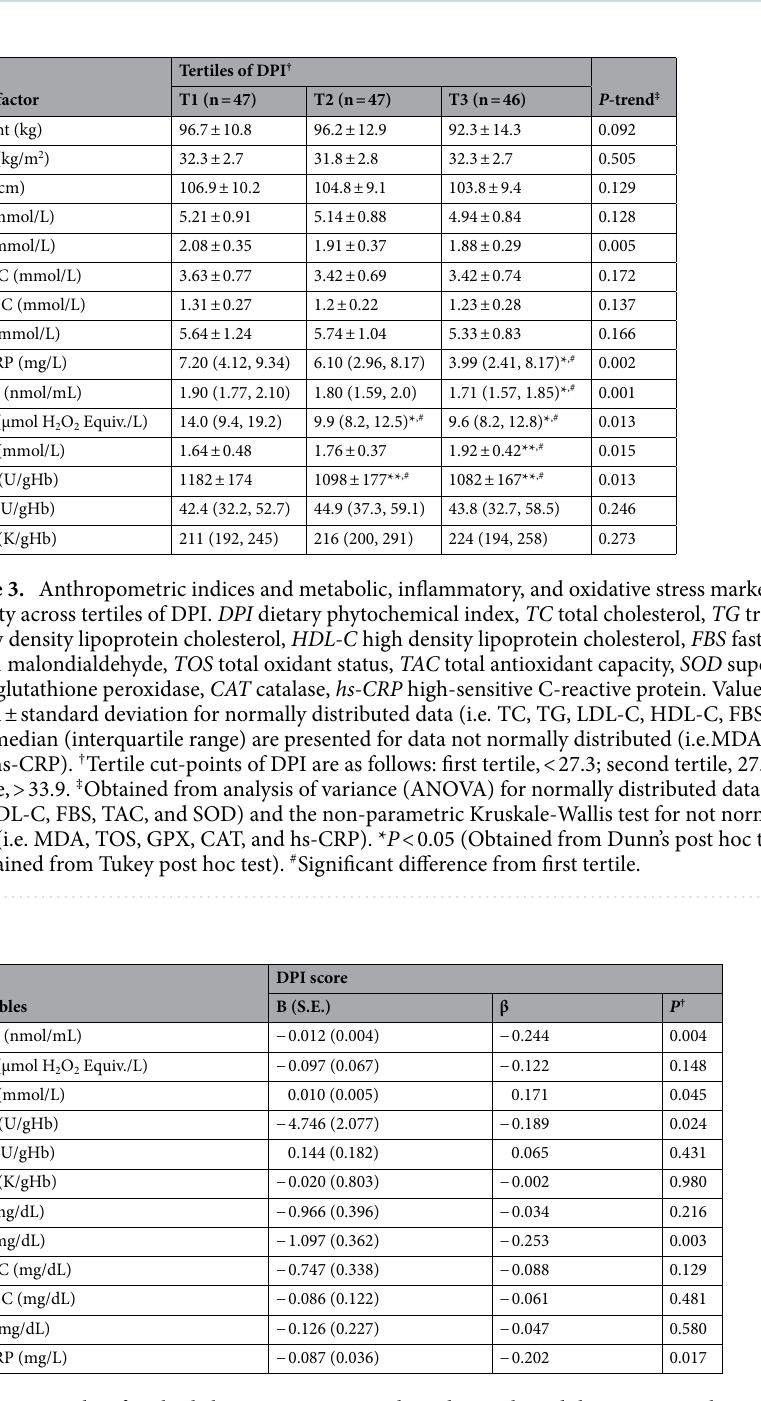
Table 4. Results of multiple linear regression analysis that evaluated the association between dependent (metabolic, inflammatory, and oxidative stress markers) and independent variables (DPI) ( n = 140). DPI dietary phytochemical index, MDA malondialdehyde, TOS total oxidant status, TAC total antioxidant capacity, SOD superoxide dismutase, GPx glutathione peroxidase, CAT catalase, TC total cholesterol, TG triglyceride, LDL-C low density lipoprotein cholesterol, HDL-C high density lipoprotein cholesterol, FBS fasting blood sugar, hs-CRP high-sensitive C-reactive protein, B unstandardized coefficient, S.E. standard error. † Adjusted for age, sex, BMI, cigarette smoking, and physical